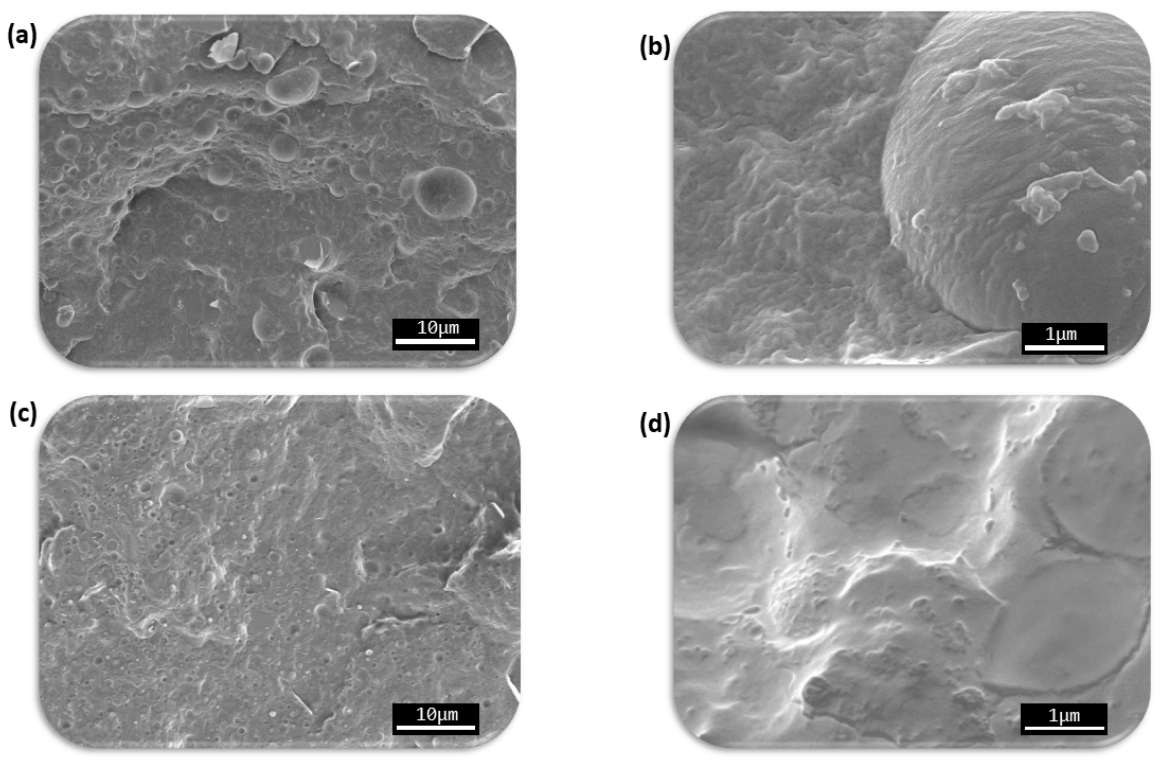
Figure 1. The SEM results. ( a , b ) SEM micrographs of the PHBV/TPU blend; ( c , d ) SEM micrographs of the PHBV/TPU/HMDI blend.